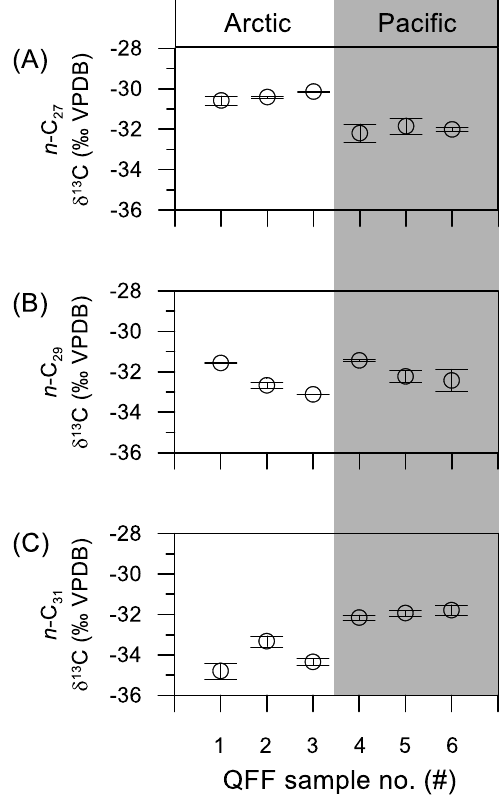
Figure 4. Average δ 13 C values of each sample for ( A ) n -C 27 , ( B ) n -C 29 , and ( C ) n -C 31 .